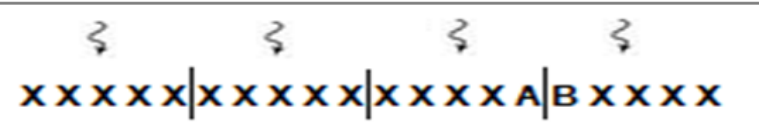
Figure 3: Boundary problem.